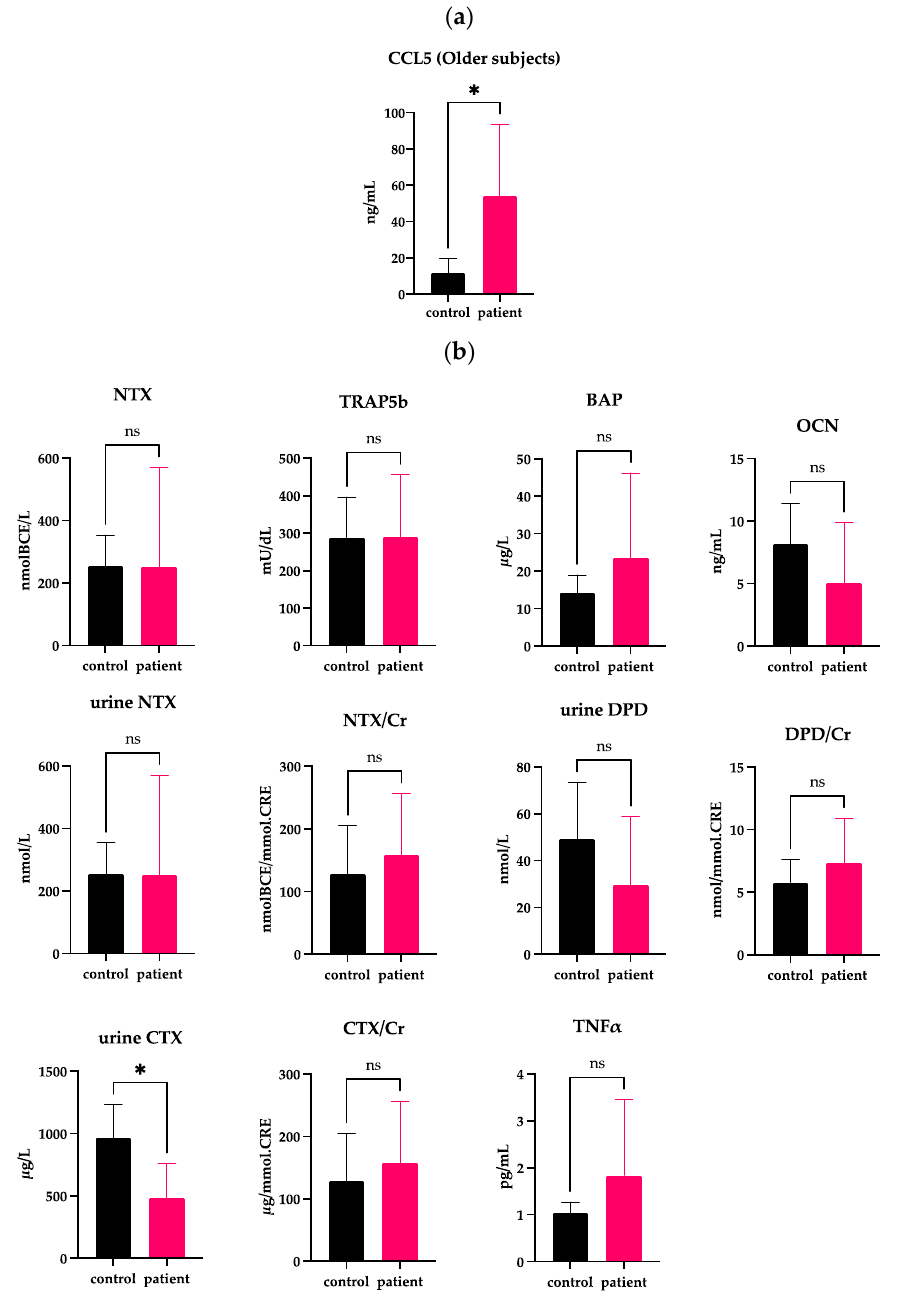
Figure 4. Measurement of CCL5 and other markers in the serum or urine obtained from subjects >42 years old (Older subjects). ( a ) Serum CCL5 levels are significantly higher in the group of DJD-TMJ subjects > 42 years old (n = 7) than in the age-matched control groups (n = 6). ( b ) Serum or urine markers related to bone metabolism and inflammation were compared between the corresponding control groups (n = 7) and the group of DJD-TMJ subjects >42 years old (n = 6). t -test, two-tailed. * indicates a significant difference at p < 0.05. Table 2. List of laboratory results for DJD-TMJ and control subjects at ≤ 42 years old (Younger sub- jects). Highlighted in yellow shows patients with systemic diseases.